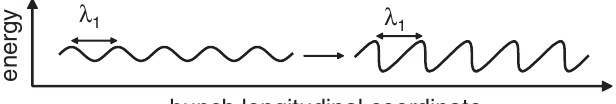
FIG. 11. Longitudinal phase space picture of the electron bunch. In the small signal regime, both the energy and the density modulations are sinusoidal at the fundamental wave- (left). Near saturation, the nonlinear modulation at the length (cid:2) 1 fundamental induces strong harmonic bunching in the beam current